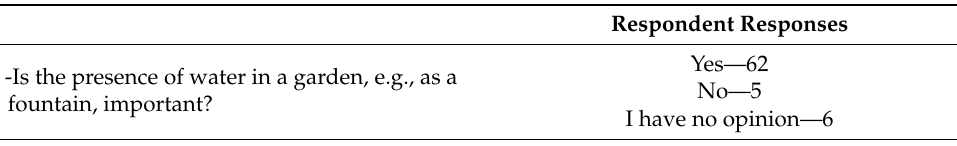
Table 7. Problems associated with water in sensory gardens—survey